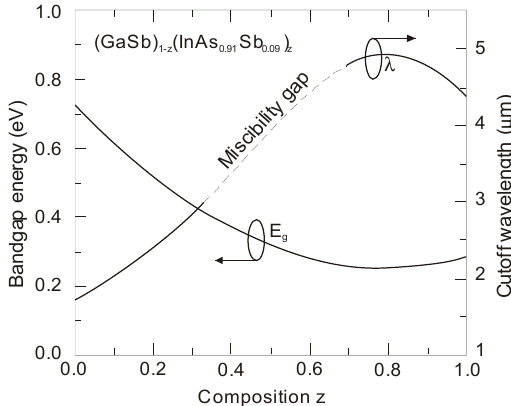
Figure 32. The energy bandgap of Ga x In 1 − x As y Sb 1–y with x and y compositions chosen in the ratio (GaSb) 1–z (InAs 0.91 Sb 0.09 ) z can be tuned continuously from ~475 to 730 meV while maintaining lattice-matching to a GaSb substrate.